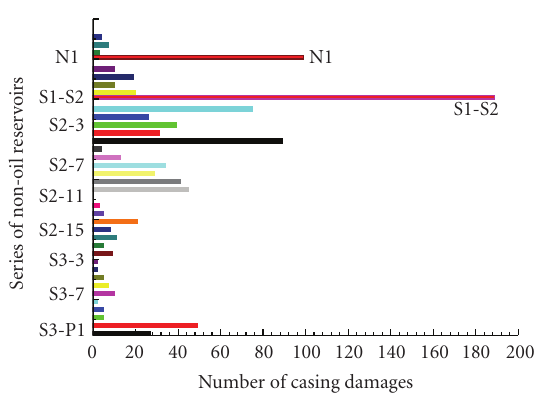
Figure 3: Statistics of oilfield well casing damages in various soil